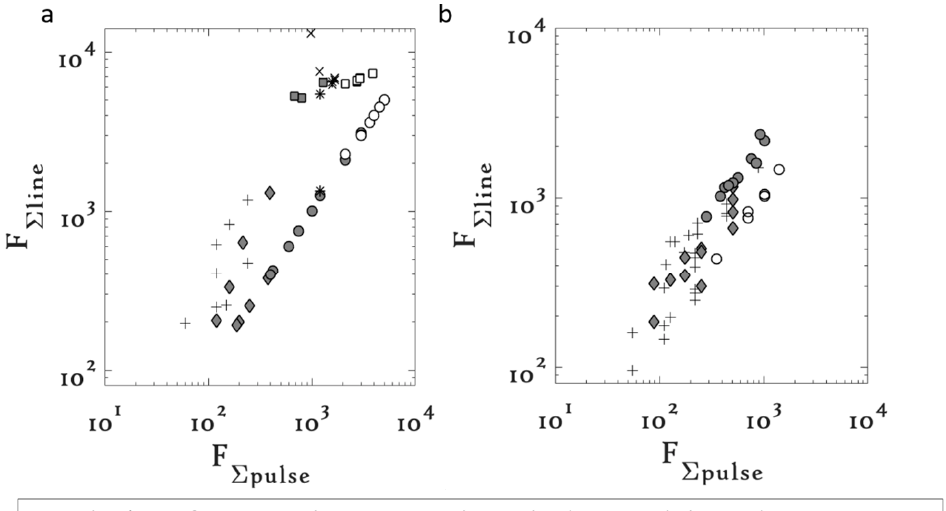
Figure 3. ஊ௟௜௡௘ vs. ஊ௣௨௟௦௘ plots on Cu at ( a ) 1 kHz and ( b ) 10 kHz [23]. (Reprinted from Optics and ܨ Figure 3. F Σ line vs. F Σ pulse plots on Cu at ( a ) 1 kHz and ( b ) 10 kHz [23]. (Reprinted from Optics and Lasers in Engineering, 66, K.M. Tanvir Ahmmed, Edwin Jee Yang Ling, Phillip Servio, Anne-Marie Kietzig, Introducing a new optimization tool for femtosecond laser-induced surface texturing on titanium, stainless steel, aluminum and copper, 258-268, 2014, with permission from